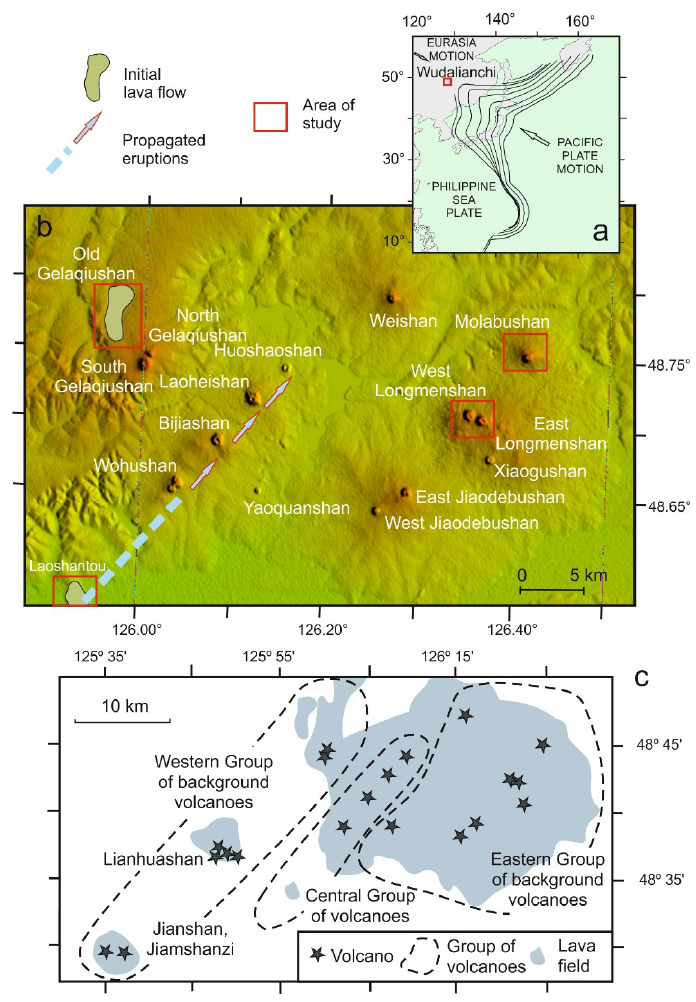
Figure 1. Location of the Wudalianchi volcanic field on the active continental margin of Eurasia ( a ), spatial position of Molabushan and Longmenshan volcanoes relative to the older Laoshantou and Old Gelaqiushan flows ( b ), and grouping of volcanoes ( c ).